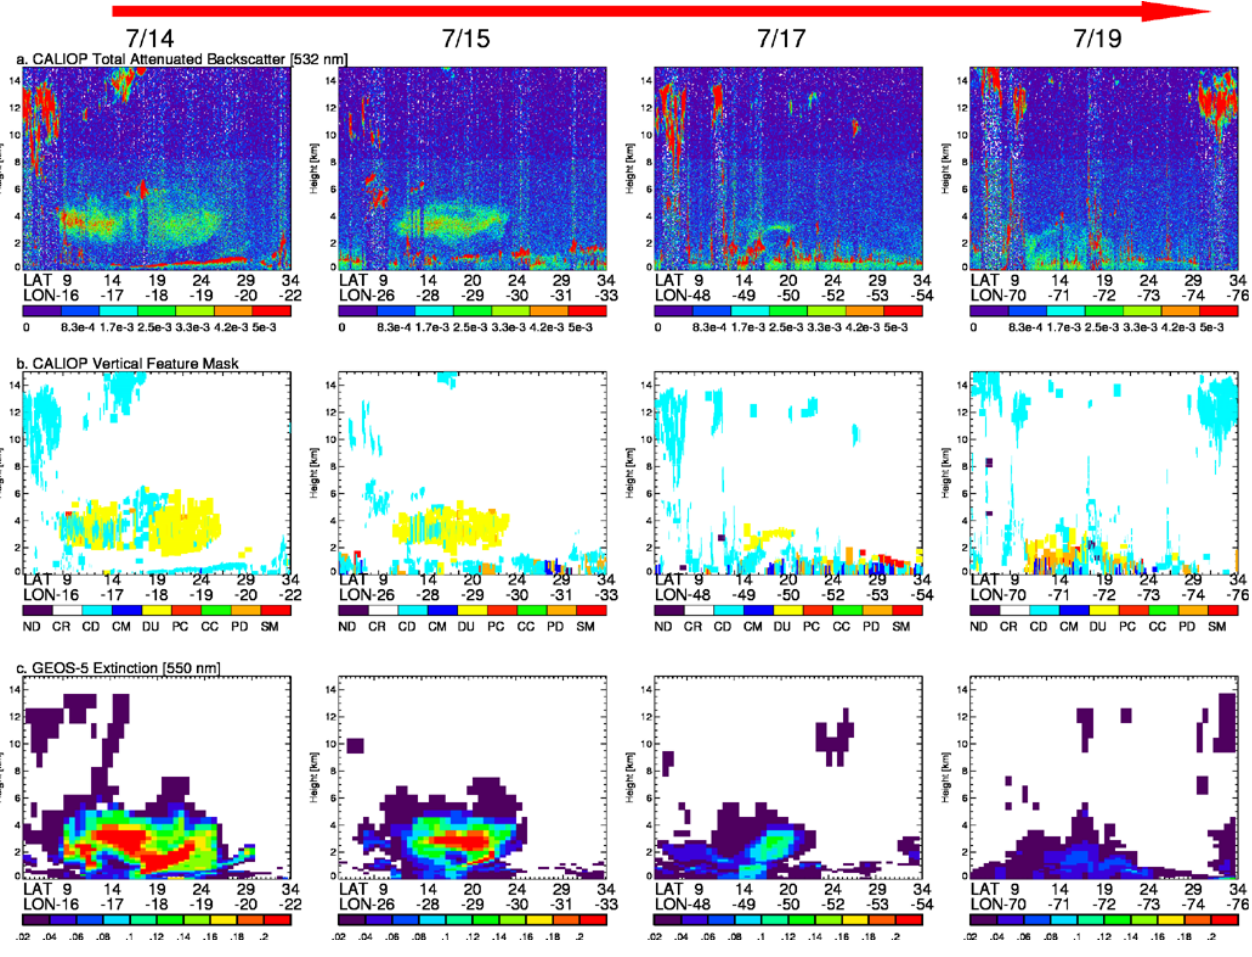
Fig. 5. CALIOP total attenuated backscatter (km − 1 sr − 1 ) (a) , CALIOP vertical feature mask (b) , and GEOS-5 extinction (km − 1 ) (c) for a dust event tracked from Africa (14 July) to the Caribbean (19